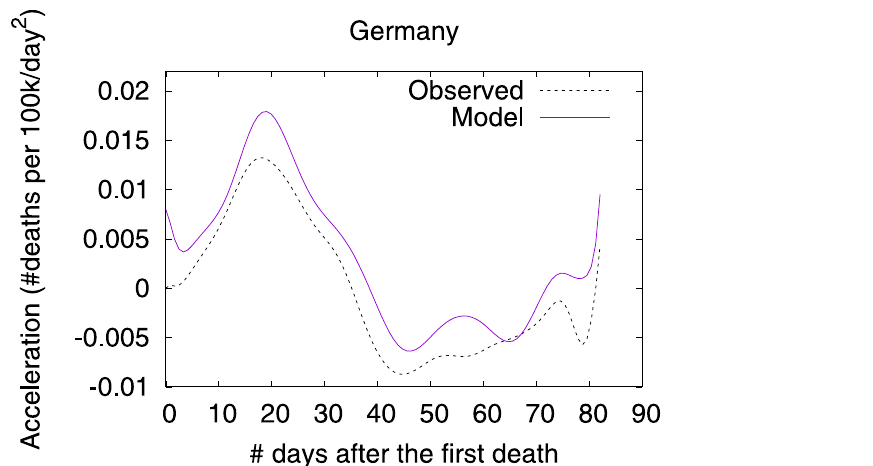
Fig 21. (Color online) projections for acceleration in Germany.